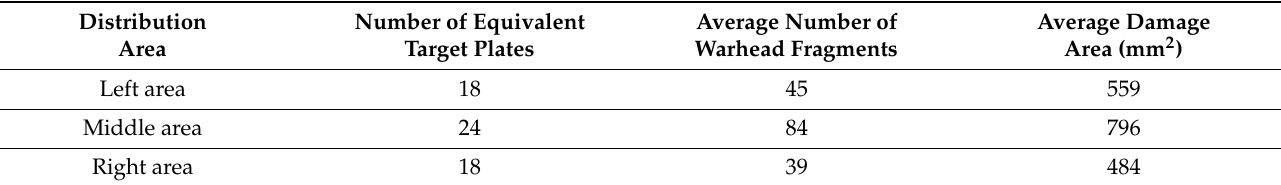
Table 3. Test data of equivalent target plate at 83.5